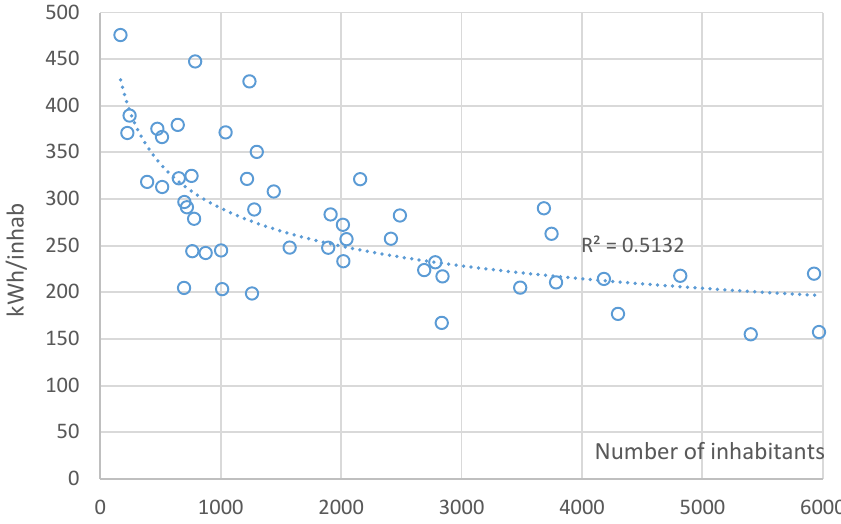
Figure 3. Relationship between the number of inhabitants and the average annual energy consumption of a municipality.